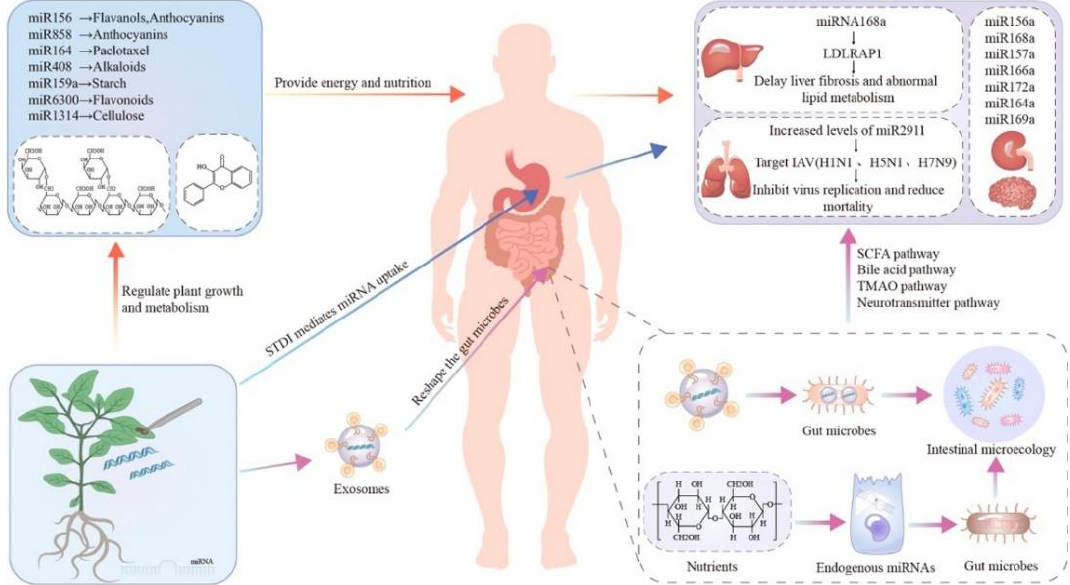
Figure 3. The intake of plant miRNA may have many effects on the body. For example, some plant miRNAs target host cell mRNA after absorption in vivo, inhibit the post-transcriptional splicing or translation process of target mRNA, and affect protein expression. At the same time, plant miRNA can enter the intestine and affect the host intestinal flora, thereby interfering with metabolism and physiology.